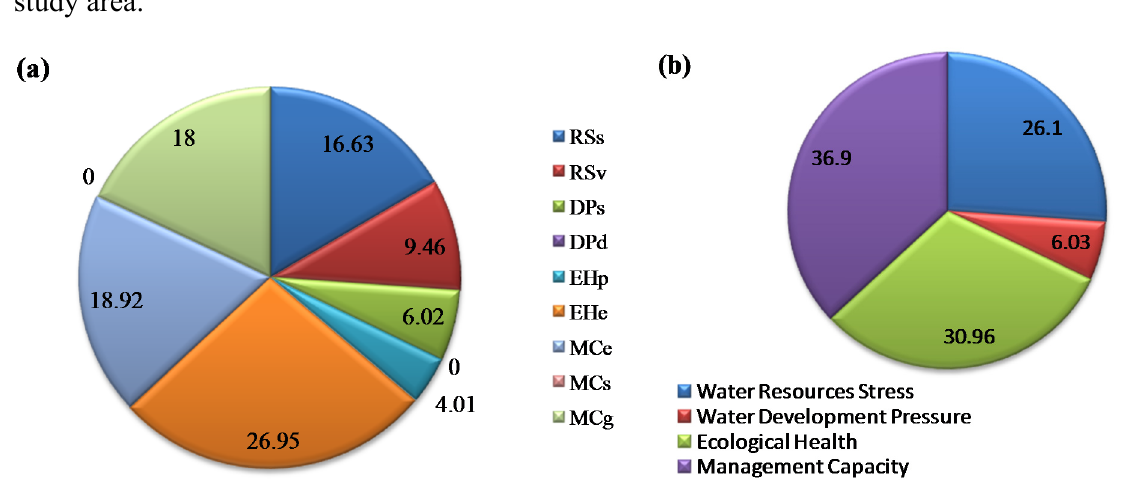
Figure 3. ( a ) Percentage of the weighted parameters for Vulnerability Index; ( b ) Share of the percentage of the weighted categories to the final Vulnerability Index for the study